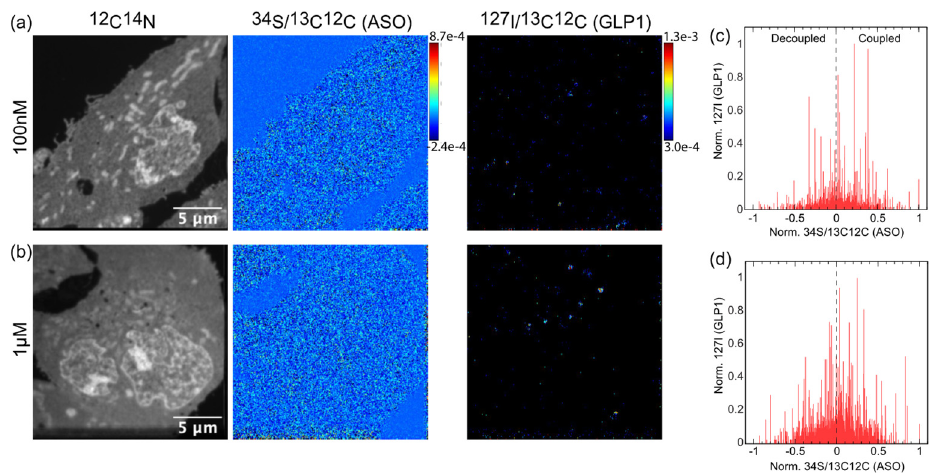
Figure 8. NanoSIMS images of GLP1R-HEK293 cells incubated for 30 min with 100 nM or 1 μ M 127 I 2 - eGLP1- 34 S 15 -ASO maleimide. ( a ) SIMS images of 100 nM incubation GLP1R-HEK293 cells, 12 C 14 N, 34 S/ 13 C 12 C (ASO), 127 I/ 13 C 12 C(GLP1). ( b ) SIMS images of 1 mM incubation GLP1R-HEK293 cells, 12 C 14 N, 34 S/ 13 C 12 C (ASO), 127 I/ 13 C 12 C(GLP1). ( c ) ROI analysis 100 nM incubation GLP1R-HEK293 cells. ( d ) ROI analysis 1mM incubation GLP1R-HEK293 cells.